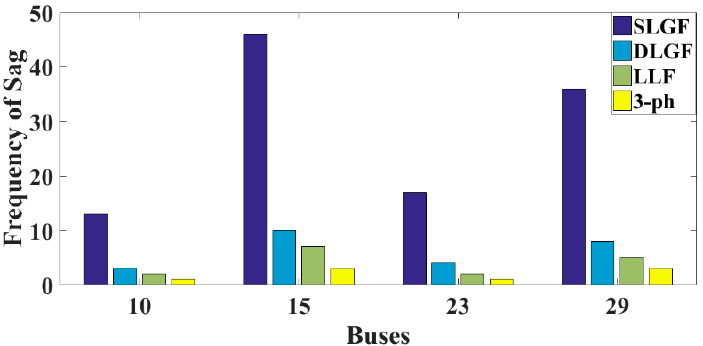
Figure 17. Sags per year for buses 10, 15, 23, and 29 with respect to different types of faults.